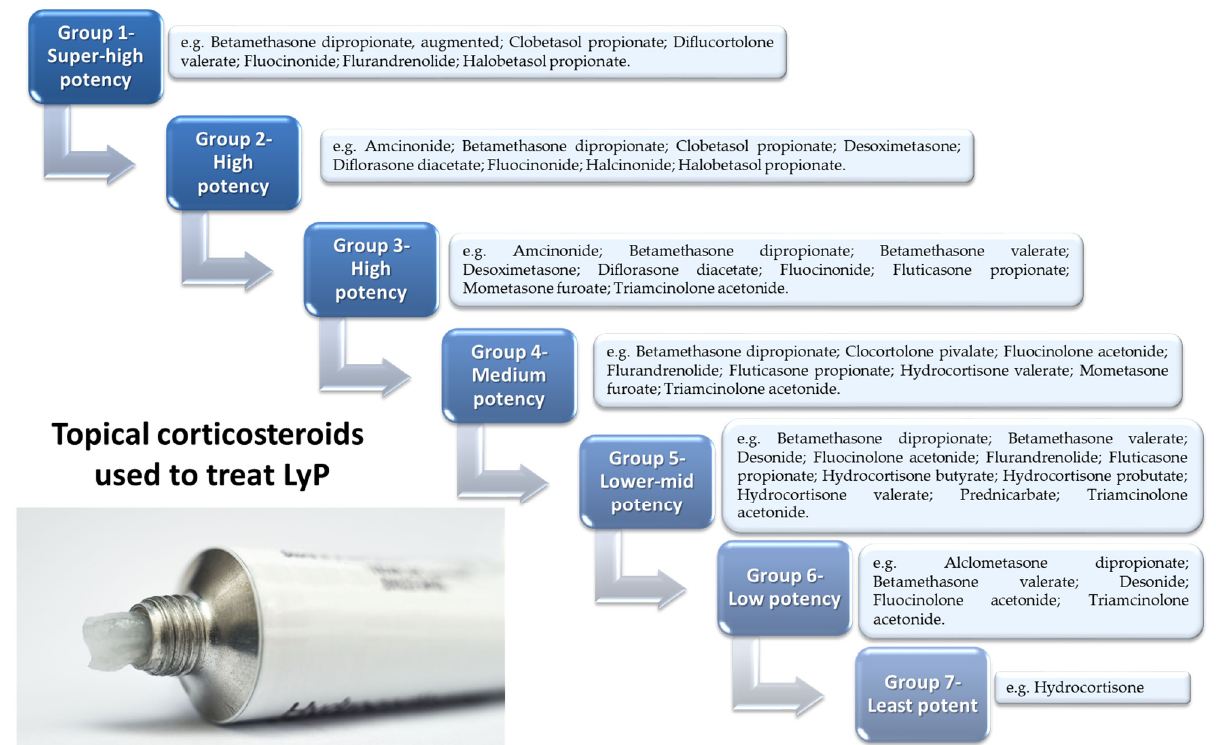
Figure 5. The most common topical corticosteroids for treatment of LyP, listed by potency according to the United States classification system: group 1 is the most potent, group 7 is the least potent. The degree depends on the concentration of the corticosteroid used, which decreases as the group number increases.